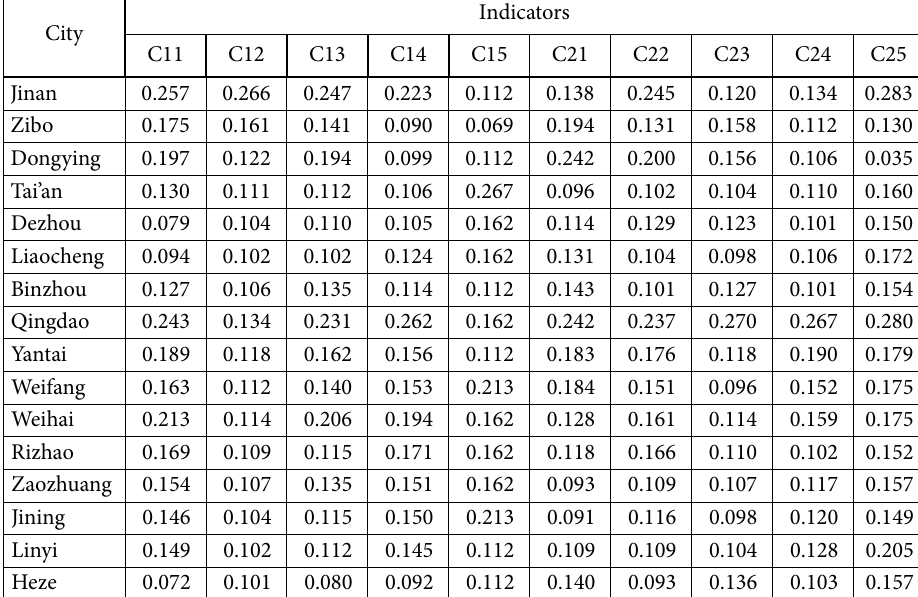
Table A2. Score of each indicator of innovation-driven development and safeguard measures